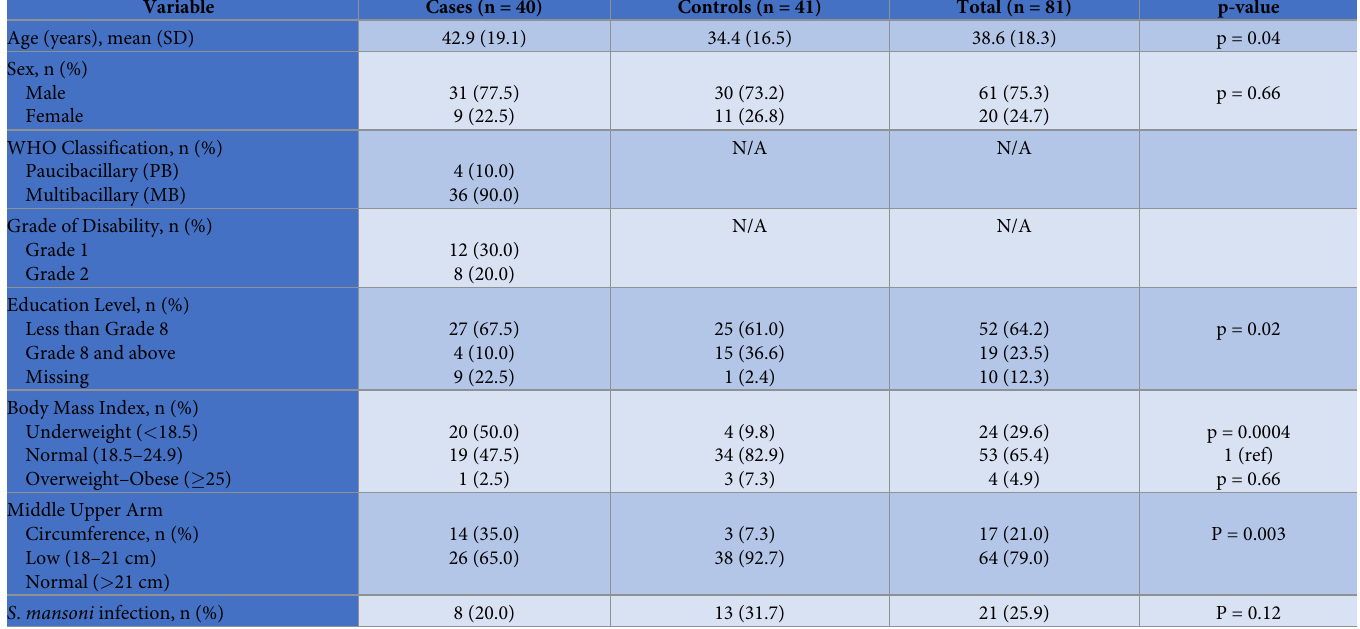
Table 1. Demographic and clinical data of study population. P-values determined by chi-square, t-test, or crude logistic regression where appropriate. An alpha = 0.05 was considered statistically